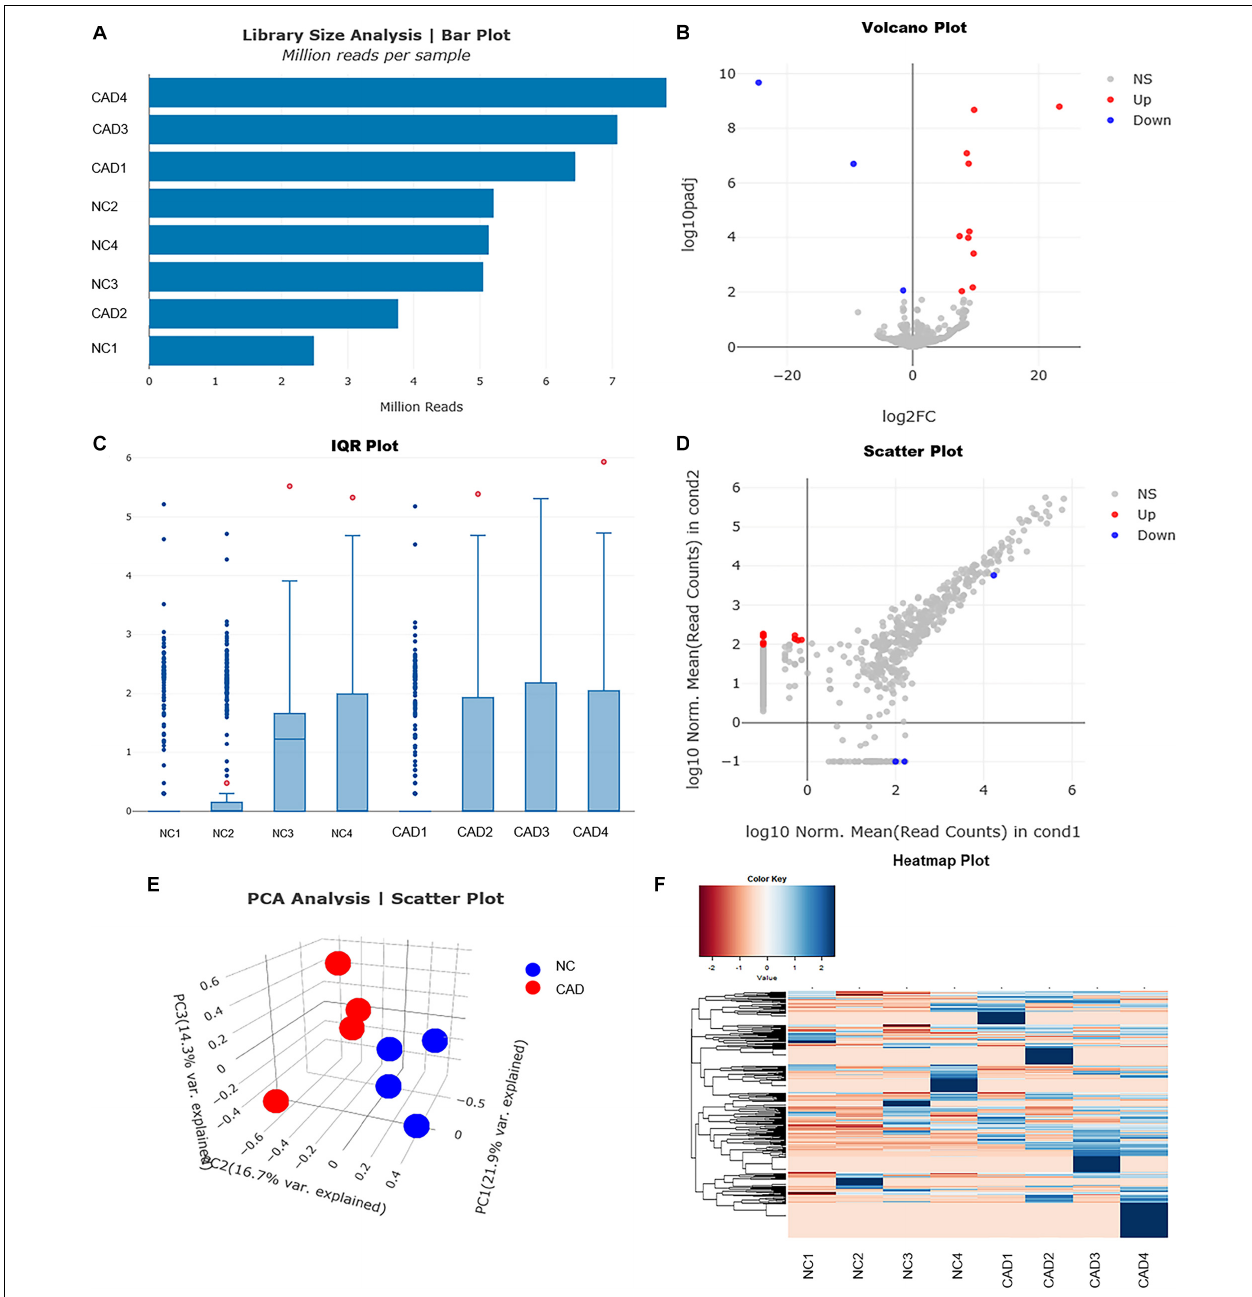
FIGURE 3 | Profiles for miRNAs of plasma exosomes from healthy and coronary artery disease (CAD) individuals. (A) Bar plot shows the reads count distribution of each sample by library size analysis. (B) Volcano plot for comparing the differentially expressed genes of exosomal miRNAs in plasma from healthy and CAD individuals after analysis with TargetScan (fold change > 1.5 and p < 0.05). (C) Inter-quartile range plot shows the data dispersion of each sample. Representative box plots of two differentially expressed miRNA that were detected in EVs from either healthy or CAD plasma are shown. (D) Scatter plot shows the relationship of read counts and the samples between the two groups. (E) Principal component analysis showing the separation of samples from healthy and CAD plasma. Each point represents a sample. (F) Heatmaps of the top differentially expressed miRNAs from plasma exosomes of healthy and CAD patients ( n = 4 each group) were identified in hierarchical clustering. The color that represents the specific value is provided in the legend on the upper-left side of the